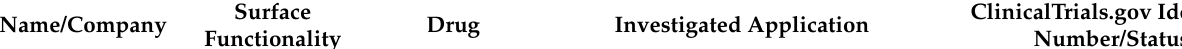
Table 4. PLGA-based NPs that have undergone clinical trials in the last